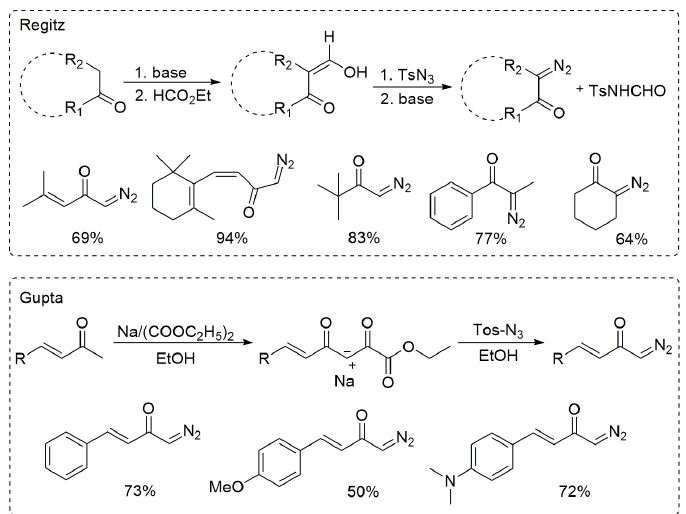
Figure 18 - Regitz and Gupta deformylating diazo transfer procedure for the preparation of